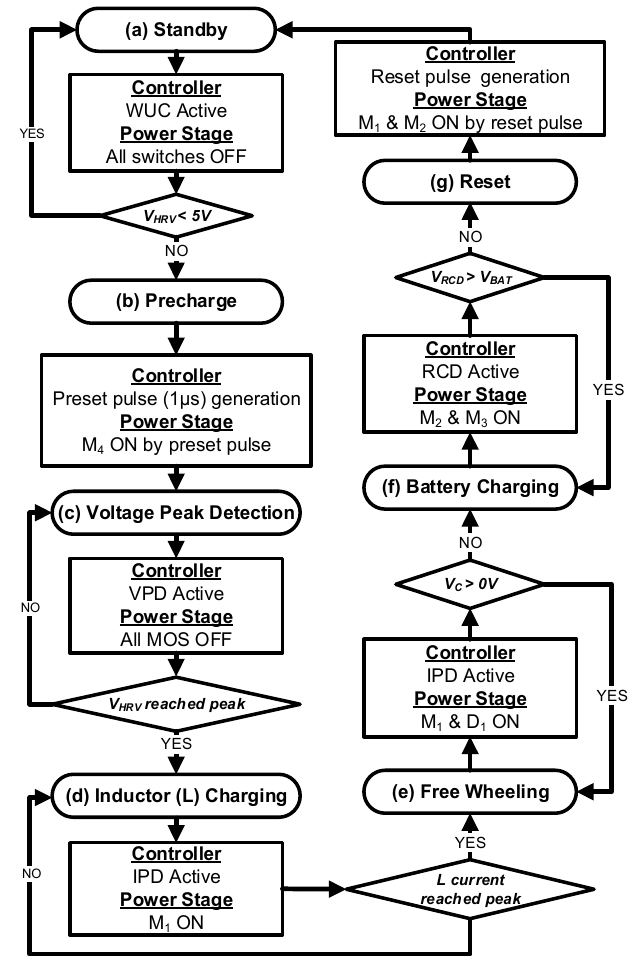
Figure 4. Proposed harvesting interface operation flow chart.